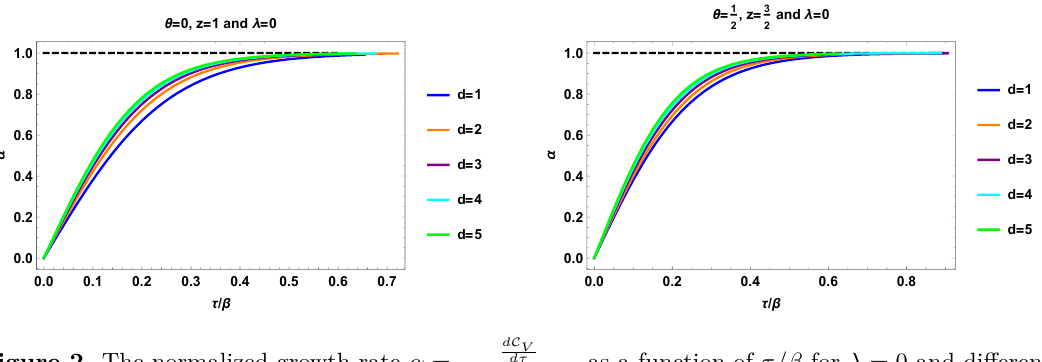
d C V as a function of τ/β for λ = 0 and different Figure 2 . The normalized growth rate α = dτ lim τ →∞ d C V dτ values of d , θ and z : Left ) θ = 0 and z = 1 . This figure is the same as figure 7 in ref. [48], since for these values of θ and z , the black brane becomes a planar AdS-Schwarzschild black hole. Right ) and z = 3 . We set L = r = r = 1 . θ = 1 h F 2 2